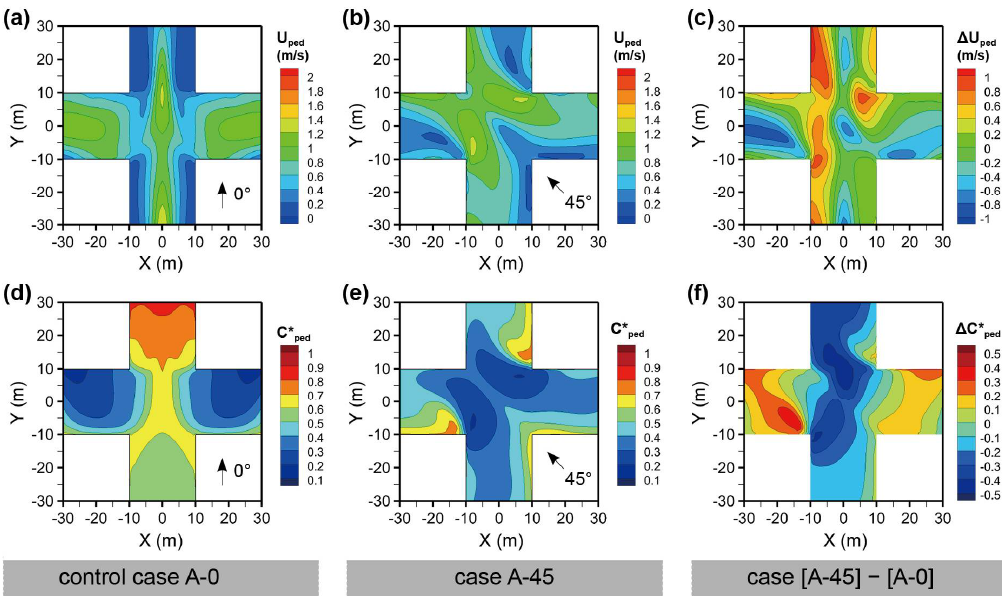
Figure 4. Wind velocity (U) and normalized pollutant concentration ( C ped∗ ) at Z = 1.5 m for Case A (regular-shaped inter- section); ( a ) (cid:1847) (cid:1868)(cid:1857)(cid:1856) for Cases A-0 and ( b ) A-45; ( c ) (cid:1847) (cid:1868)(cid:1857)(cid:1856) between Cases A-45 and A-0; ( d ) (cid:1829) (cid:1868)(cid:1857)(cid:1856)∗ for Cases A-0 and ( e ) A-45; ( f ) (cid:1829) (cid:1868)(cid:1857)(cid:1856)∗ between Cases A-45 and A-0.